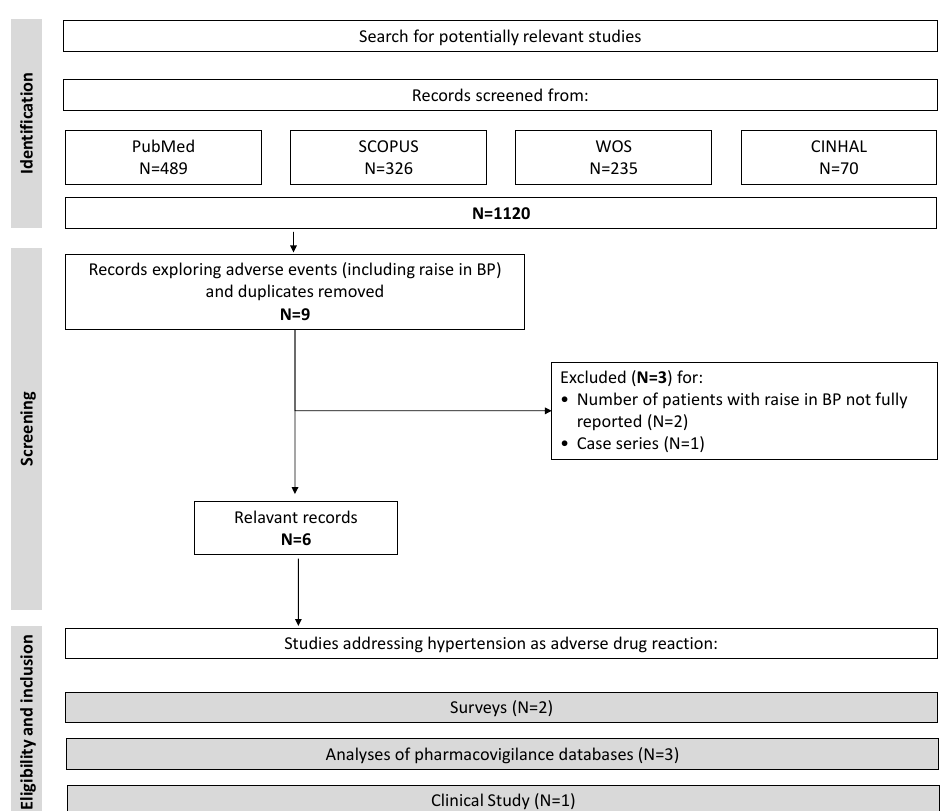
Figure 1. Criteria used for selection of studies.